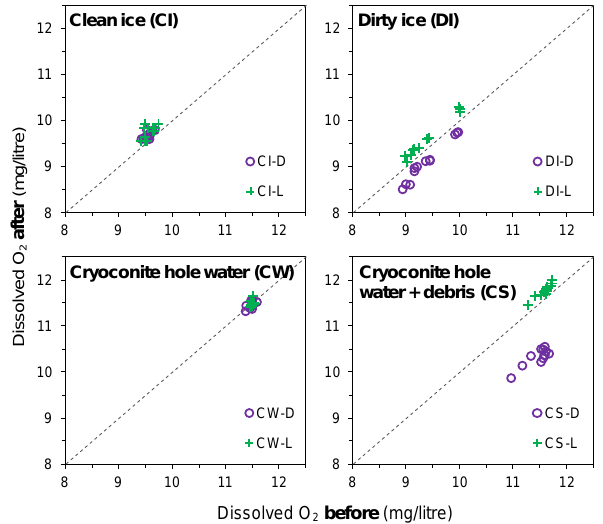
Figure 10. Dissolved O 2 concentrations before and after incuba- tion in experiments with 12 light (purple circles, “-L”) and 12 dark bottles (green crosses, “-D”) of each sample type. Samples plotting ABOVE the dashed line GAINED oxygen. Light samples indicate the balance between rates of respiration and photosynthesis, while dark samples reflect respiration rates only.